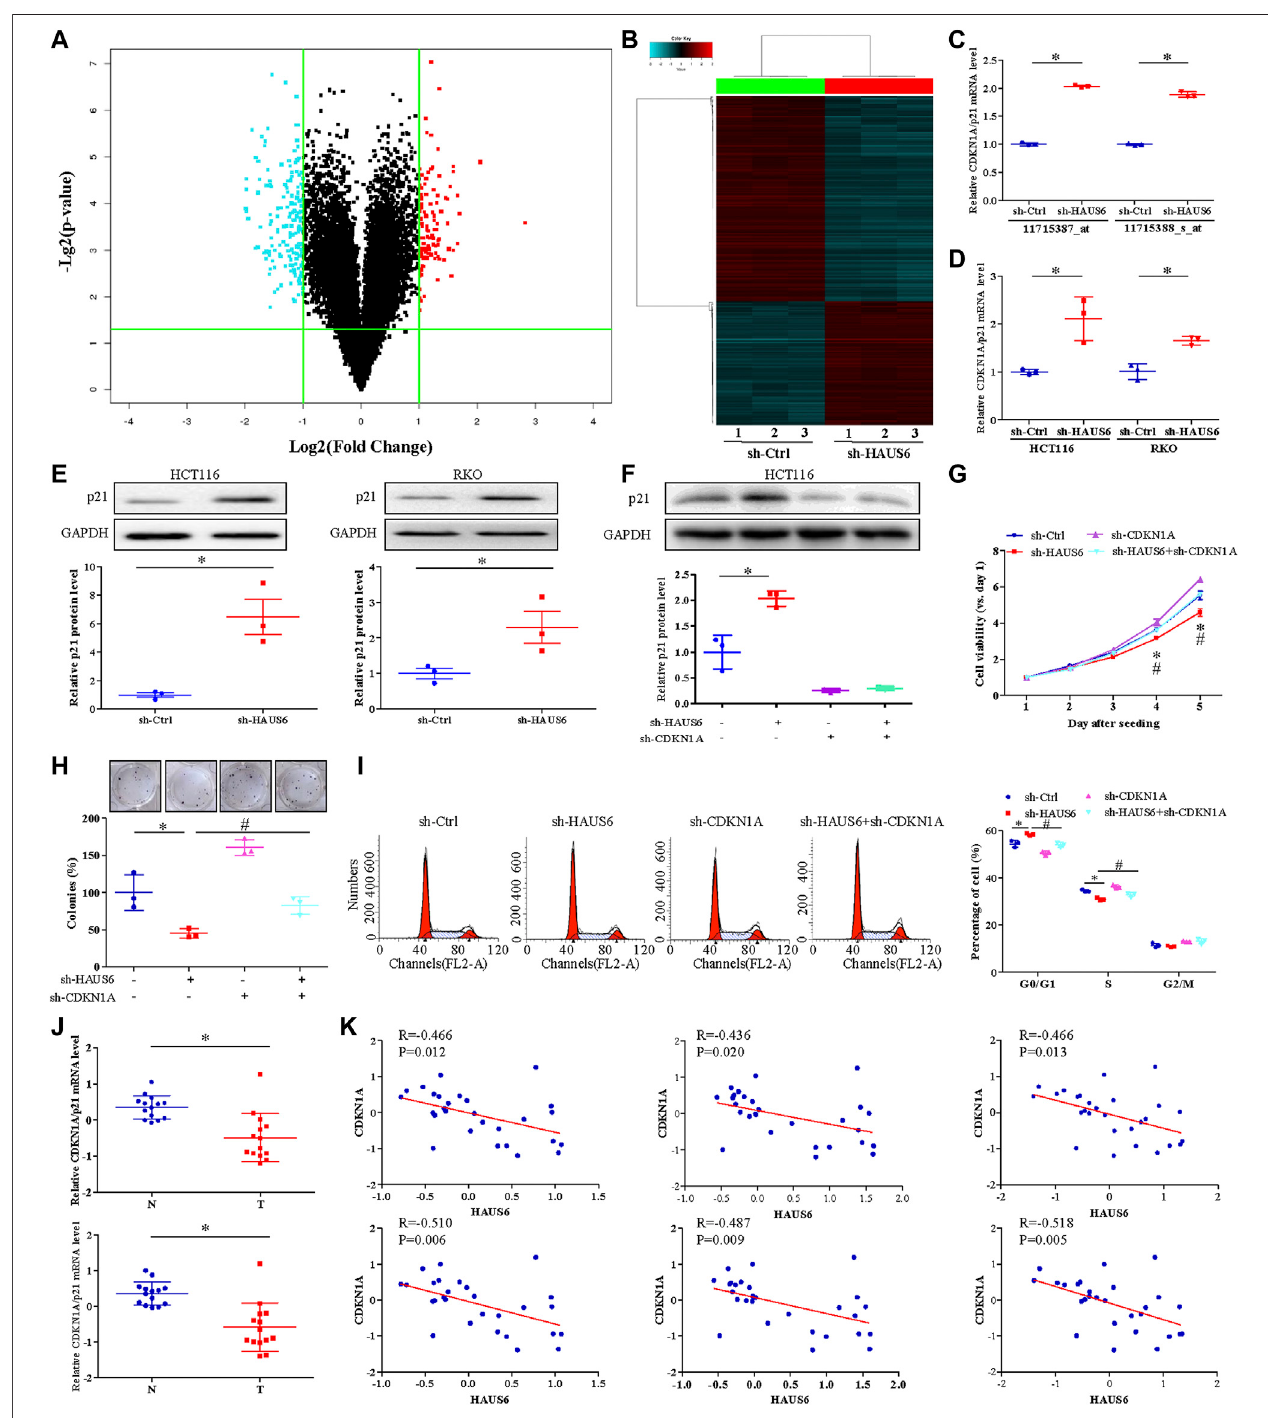
FIGURE 5 | HAUS6 knockdown suppresses cell proliferation by increasing p21 expression. (A) A volcano plot and (B) hierarchical clustering plot showing DEGs (fold change > 2, p < 0.05) between HCT116 cells transduced with shRNA against HAUS6 or control shRNA (n (cid:1) 3). (C,D) CDKN1A/p21 mRNA levels was assessed by (C) cDNAmicroarrayinHCT116cellstransducedwithshRNAagainstHAUS6orcontrolshRNAand (D) quantitative RT-PCRinHCT116andRKOcellstransducedwith shRNA against HAUS6 or control shRNA. GAPDH was used as an internal control. Mean ± SD; n (cid:1) 3; * p < 0.05, vs. sh-Ctrl by independent Student ’ s t test. (E) Protein levels of p21 in HCT116 and RKO cells after HAUS6 knockdown was assessed by western blot (n (cid:1) 3). GAPDH was used as a loading control. Band intensities were quanti fi ed using ImageLab software. Mean ± SD; n (cid:1) 3; * p < 0.05, vs. sh-Ctrl by independent Student ’ s t test. (F) Expression of p21 protein in HCT116 cells transduced with shRNAs against HAUS6, CDKN1A or both, or control shRNA was assessed by western blot (n (cid:1) 3). GAPDH was used as a loading control. Band